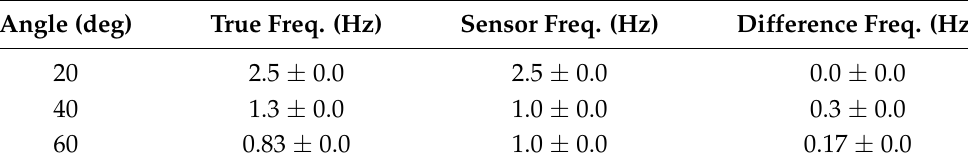
Table 1. Results of the frequency response to three different angle deformations given to the sensor. “Difference freq.” is the absolute value of the true frequency minus the sensor frequency.